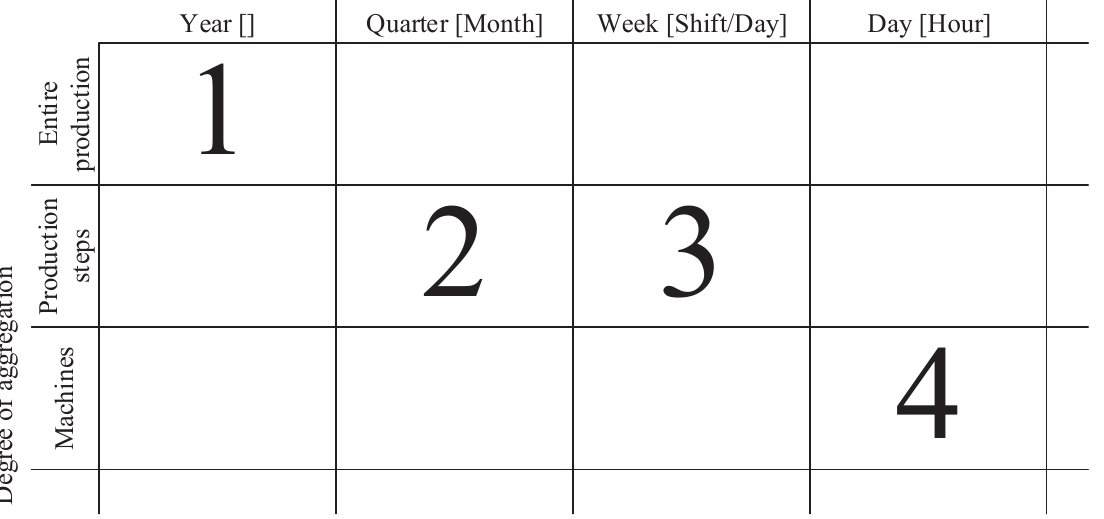
Figure 2. Grid in which possible application cases can move along the two dimensions, planning horizons with the specified length of a period length and degree of aggregation. Four specific application cases are additionally